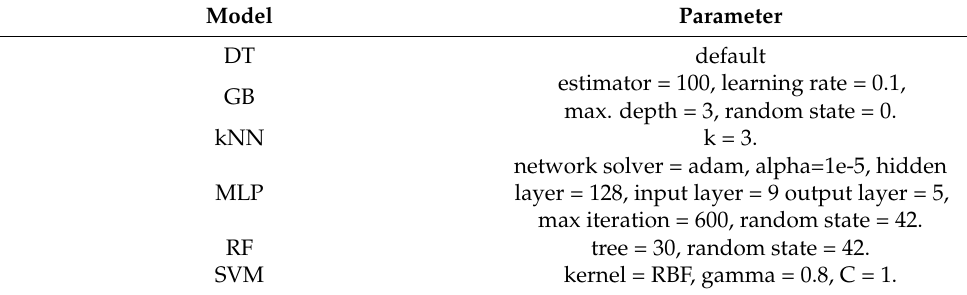
Table 4. Model parameters.